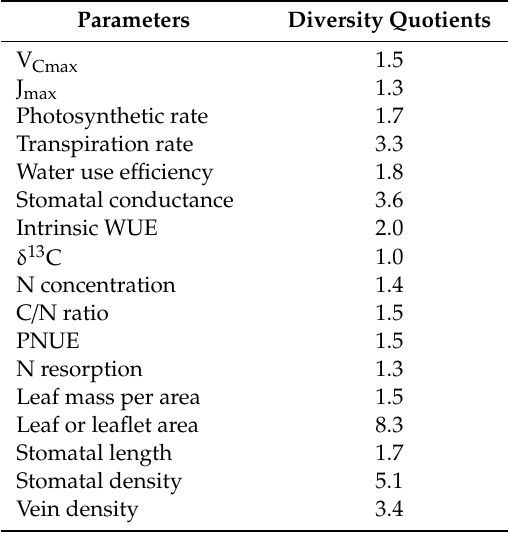
Table 3. Diversity quotients (maximum value / minimum value) across study